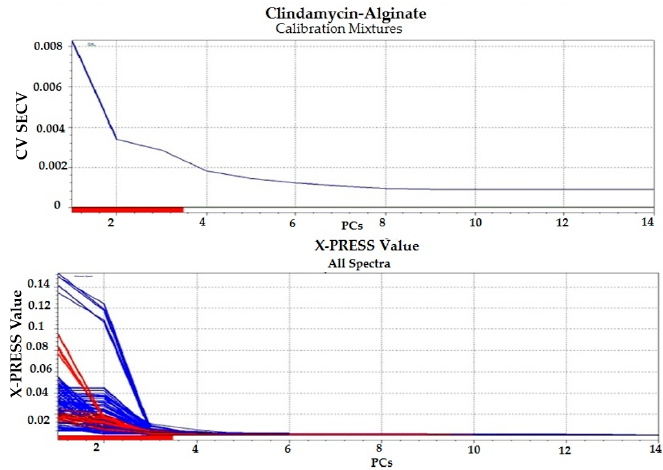
Figure 4. Selection of appropriate number of partial least square (PLS) components for clindamycin- alginate calibration mixtures. Blue color for calibration set (C-set), while red color for validation set (V-set).